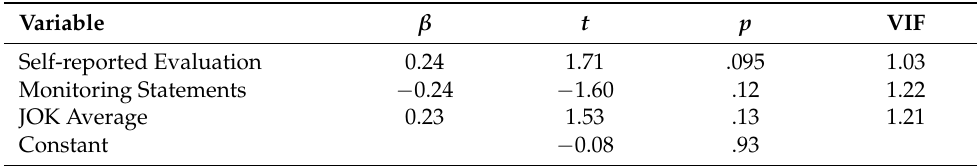
Table 8. Multiple linear regression model predicting performance on the first activity with self- reported evaluation, monitoring statements, and JOK